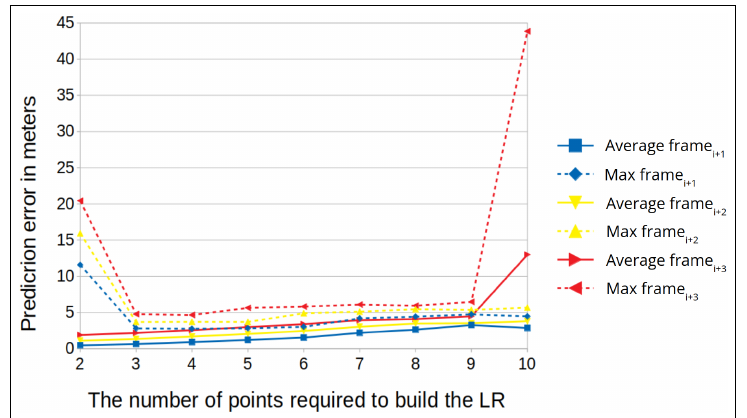
Figure 12. The prediction error (in meters) vs. various window sizes for an altitude of 50 m (average for the two locations).